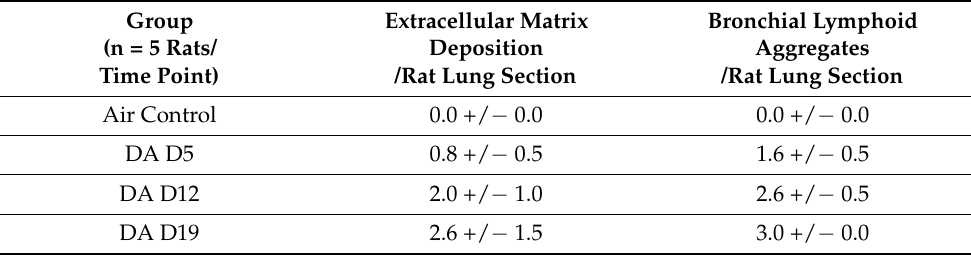
Table 1. Bronchi affected by extracellular matrix deposition and adjacent lymphoid hyperplasia af- ter DA exposure.